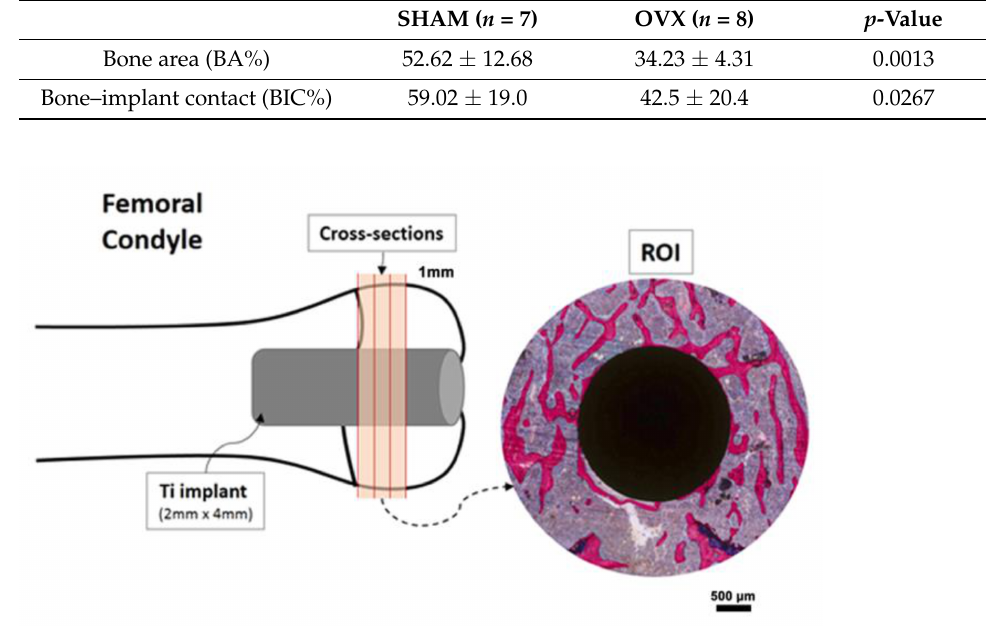
Figure 3. Illustration for the sectioning procedure. Cross-sections were made starting 1 mm from Table 1. Millimeter circumferential area in which the bone area (BA %) as well as the bone–implant contact (BIC %) were